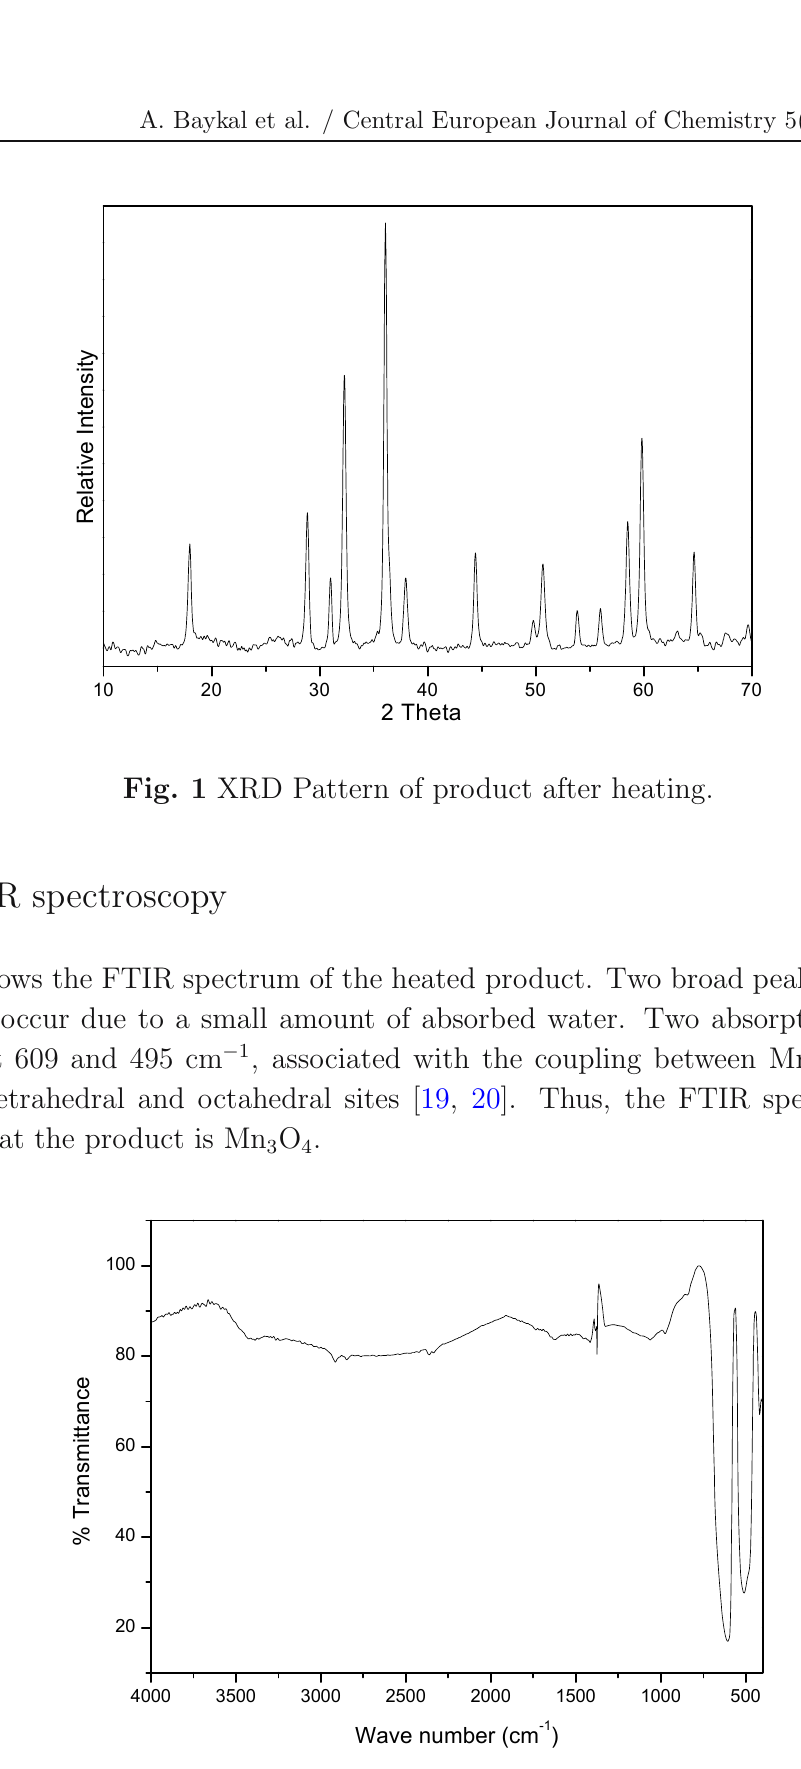
Fig. 2 FTIR spectra of heated product (in